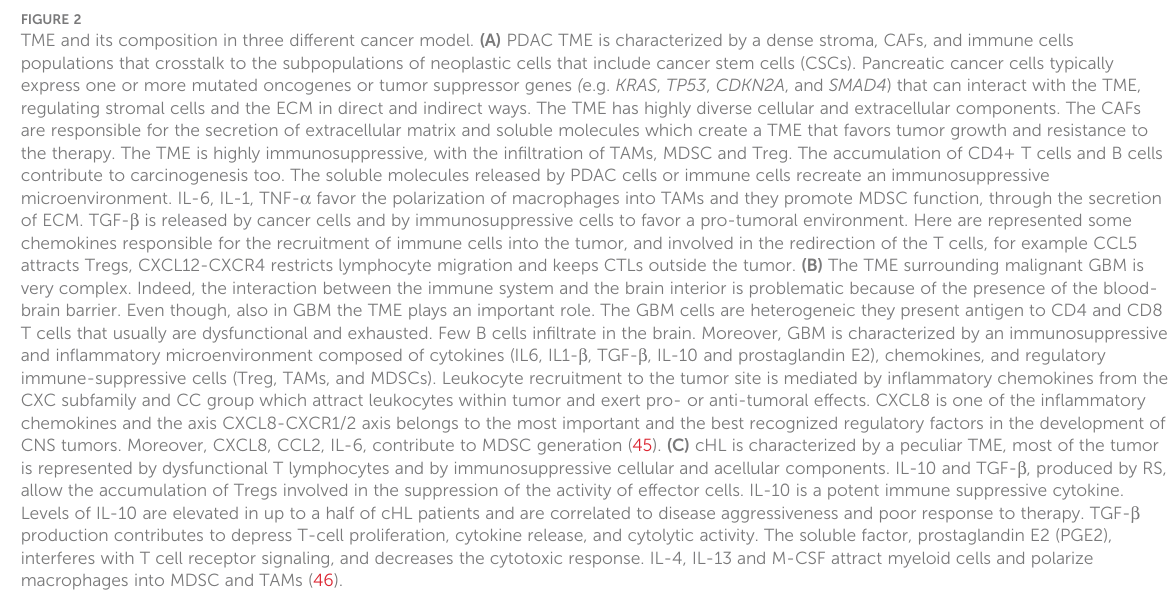
Figure 3. Five individual strategies are discussed. These include promoting T cell migration into cold tumors, reducing myeloid populations, targeting Tregs, increasing the activity of T cells to promote a cytotoxic response and fi nally to generating